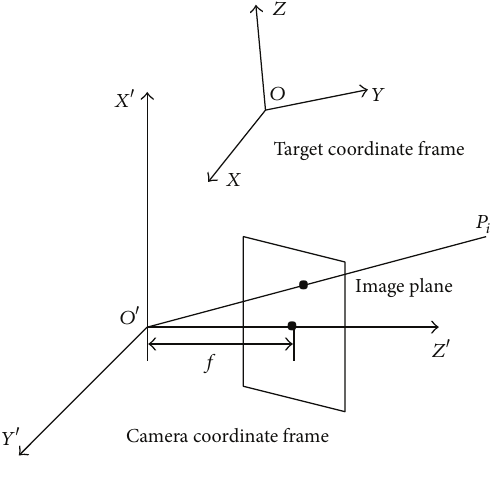
F 1: Coordinate frames in the pose estimation